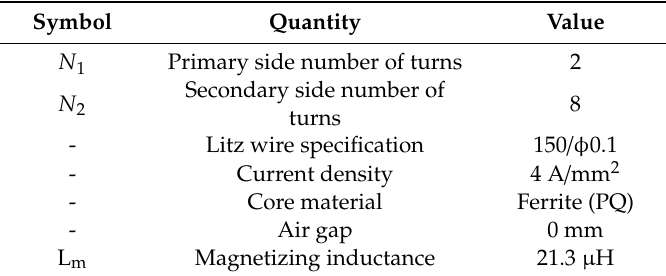
Figure 10. Overview of high frequency transformer. Table 3. Parameters of transformer 1.